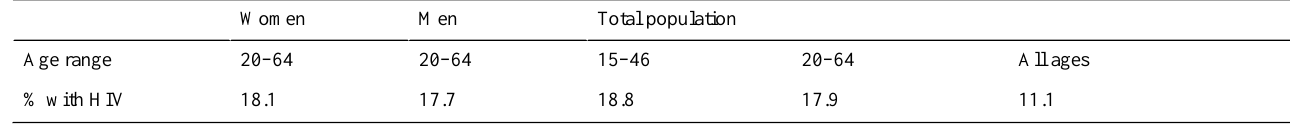
Table 1. Estimated HIV prevalence rates in South Africa [9].